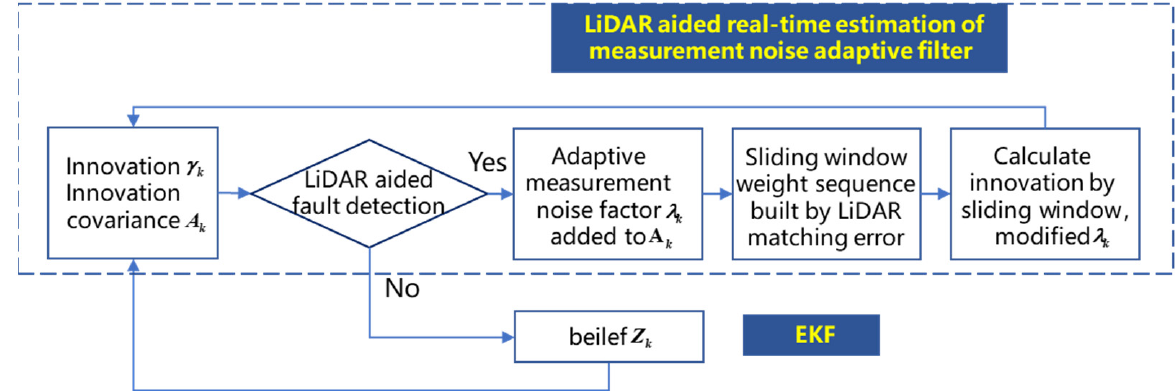
Figure 3. Schematic diagram of the LiDAR aided measurement noise estimation adaptive filter. The specific implementation of the LiDAR aided real-time measurement noise estima- tion adaptive filter algorithm is shown in the following steps. An adaptive measurement noise factor λ k is added to the innovation covariance A k to produce Equation (27):